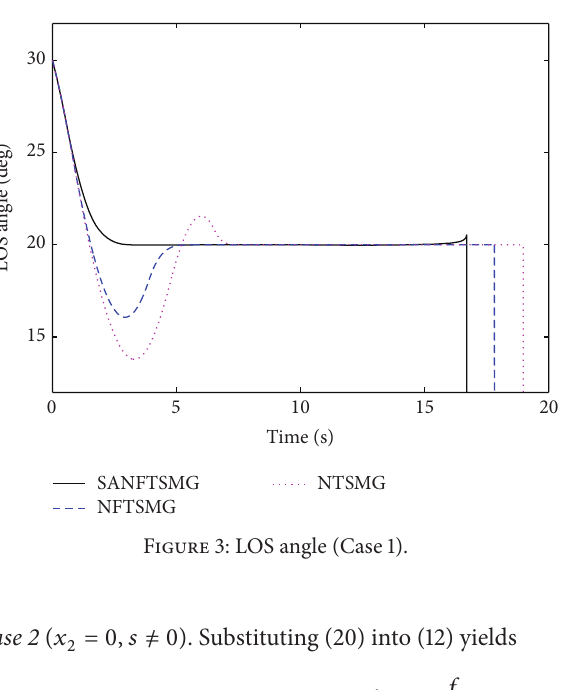
Figure 2: Trajectories of missile and target (Case 1).